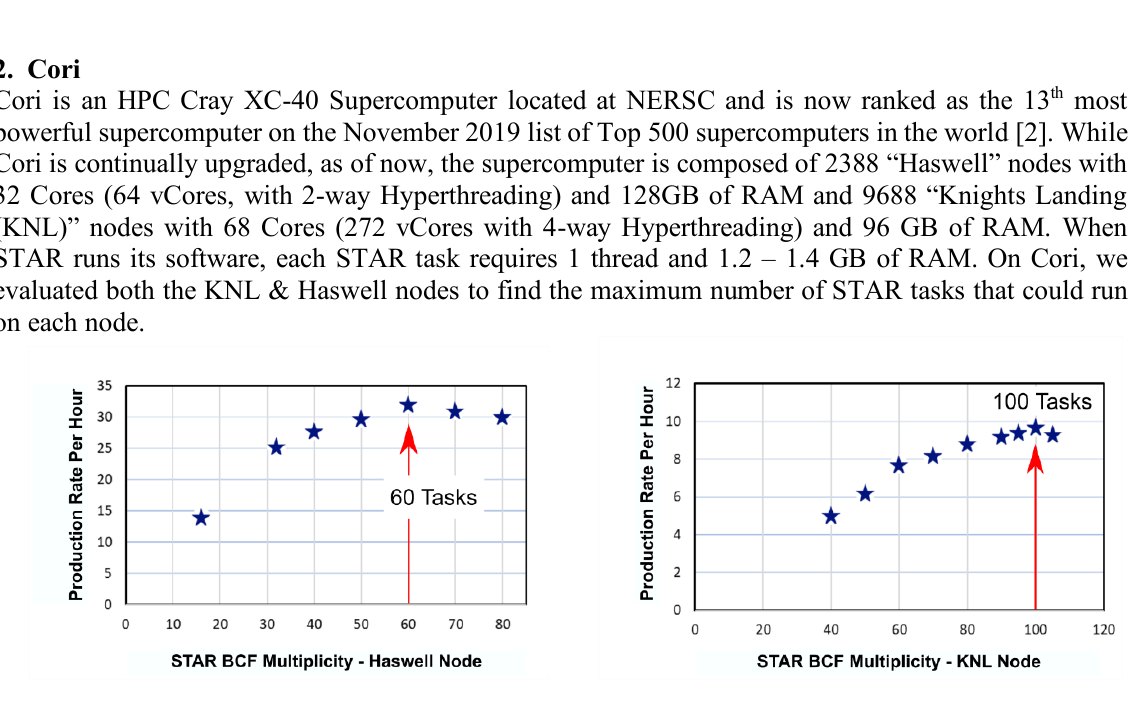
Figure 1. The two plots are showing the number of STAR tasks, known as ROOT4STAR (R4S), being produced per hour as the number of parallel tasks is increased. The left plot is the test ran on Haswell while the right plot is the test KNL. The x-axis is the total number of parallel tasks running, the y-axis is number of hours to complete the